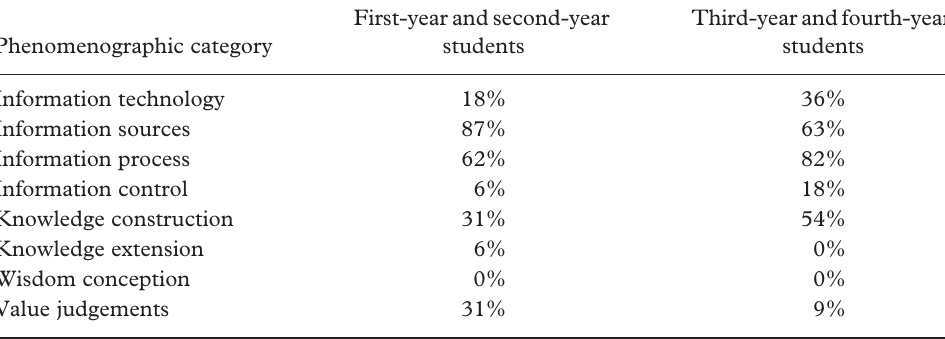
Table 2. Student post-course perceptions of information